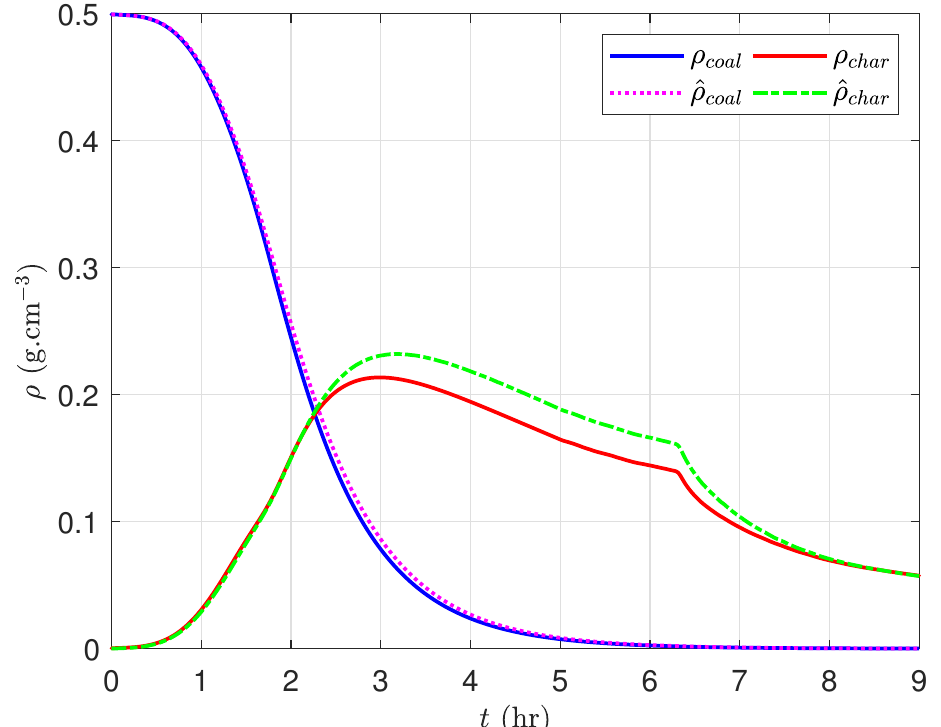
Figure 9. True and reconstructed solid densities with time.